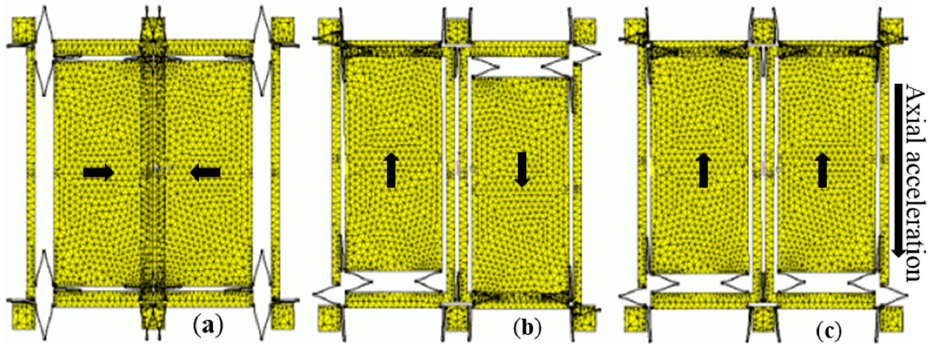
Figure 2. Working modes of the gyroscope. ( a ) Drive mode; ( b ) Sense mode with Coriolis force; ( c ) Sense mode with axial acceleration.